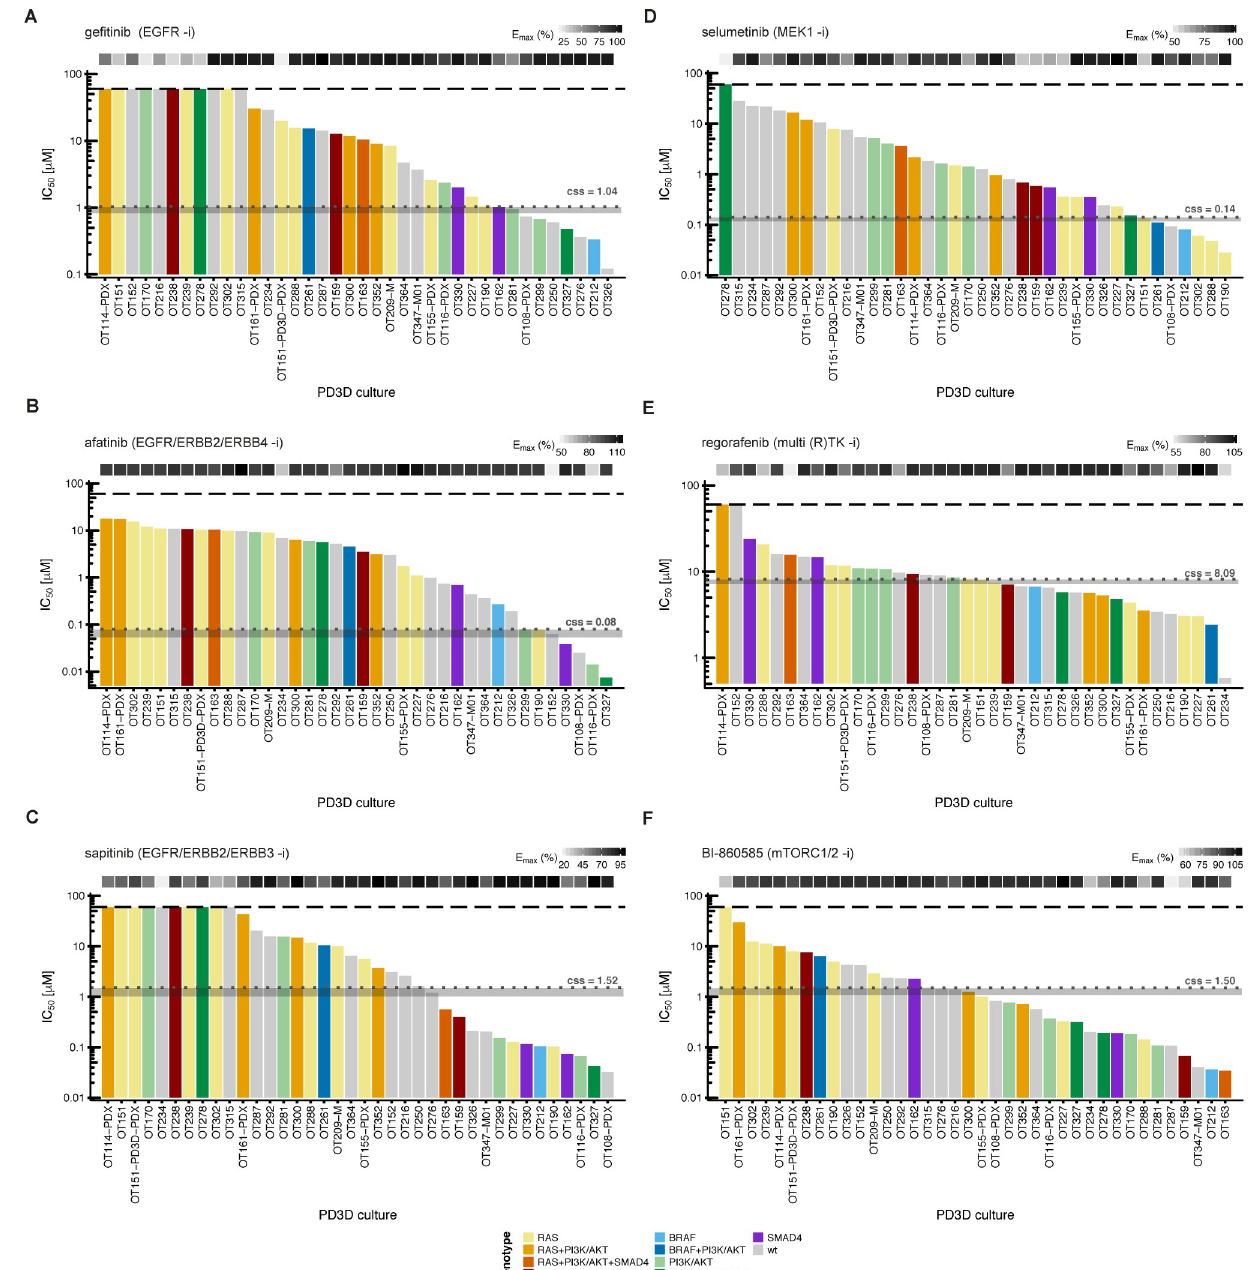
Fig 2. In vitro drug response waterfall plots of 38 organoid cultures show individual patterns of resistance and sensitivity. IC 50 values for 38 in vitro models were determined with a semi-automated drug response assay platform. The lower and upper assay cutoffs were 0.003 μ M and 60 μ M. Drug efficacy (E max ) was included as additional measure of response, indicated with light grey to black boxes according to percent efficacy above the waterfall plot. The genotype of each culture according to panel sequencing is color-coded according to the legend given at the bottom of the figure. Area (grey) of achievable steady state in vivo plasma concentrations (c ss ) are given in μ M and indicated with grey dotted lines. ( A-C ) IC 50 values for small molecules gefitinib, afatinib and sapitinib, targeting the ERBB receptor(s) ERBB1/EGFR, ERBB2/Her2, ERBB3 and ERBB4. ( D ) Inhibition at the level of MEK1/2 with selumetinib. ( E ) Response to the multikinase inhibitor regorafenib. ( F ) Treatment with the mTORC1/2 inhibitor BI- 860585. The BRAF G466R and BRAF G466V mutations in tumors OT170 and OT327, respectively, are not included in the figure, as their gene products are considered kinase-dead [77]